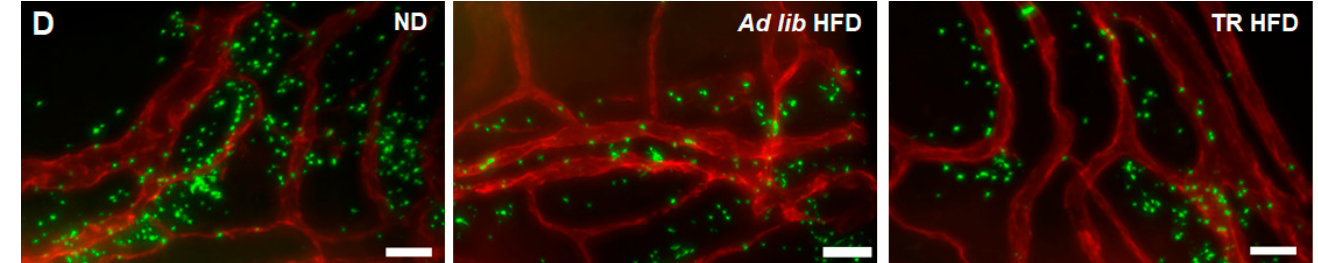
Figure 3. Inflammatory response of the cornea to abrasion. ( A ) The distribution of neutrophils over the limbal (L), paralimbal (PL), parawound (PW), paracentral (PC) and central (C) regions of the corneal stroma at 30 h after wounding ( n ≥ 6). ( B ) Data showing platelet counts at the limbus 30 h after wounding ( n ≥ 6). ( C ) Representative images of the abraded cornea of ad libitum ND, ad libitum HFD, and TR HFD 30 h after abrasion, showing extravasated neutrophils (green, anti-Ly-6G) and vasculature (red, anti-CD31) at the limbus. ( D ) Representative images of the abraded cornea of ad libitum ND, ad libitum HFD and TR HFD 30 h after abrasion, showing extravasated platelets (green, anti-CD41) and vasculature at the limbus. Data expressed as mean ± SD. * p ≤ 0.05, ** p ≤ 0.01, **** p ≤ 0.0001 (ad libitum HFD compared to ad libitum ND); †† p ≤ 0.01 and †††† p ≤ 0.0001 (TR HFD compared to ad libitum ND). Scale bars: C = 34 µ m; D = 35 µ